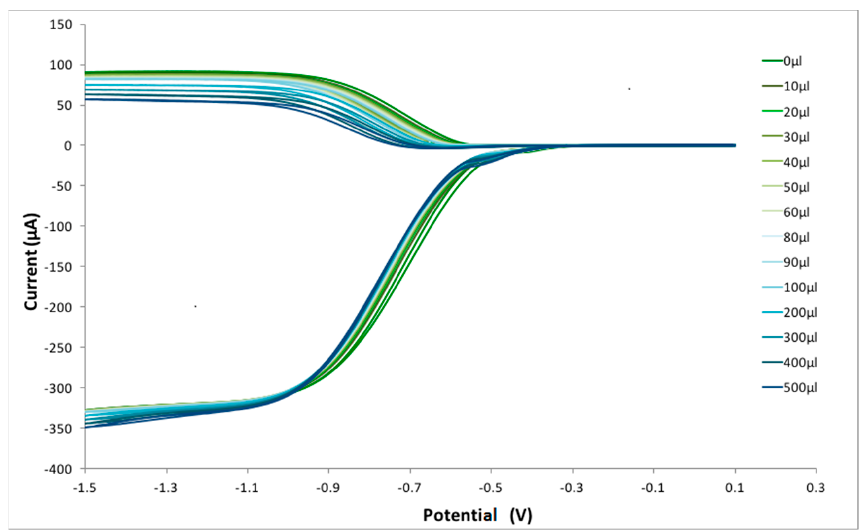
Figure 11. Voltammogram showing the effect of eriodictyol on the superoxide redox reaction for each added aliquot. Antioxidants 2018 , 7 , x FOR PEER REVIEW 14 of 20